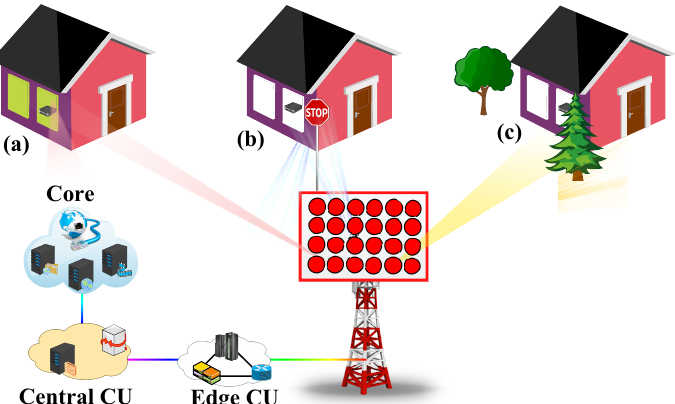
Figure 14. Effects of ( a ) low-e glass, ( b ) non-ideal LoS condition, and ( c ) tree foliage on high-frequency solution (adapted from